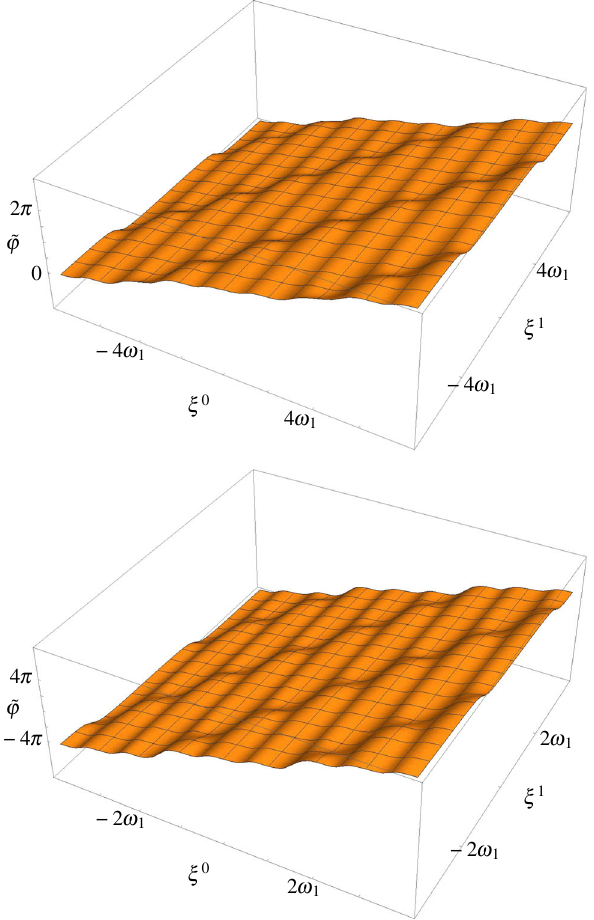
Fig. 7 The solution with D 2 < 0 for two distinct Bäcklund param- eters. The background solution has energy density E = 3 μ 2 / 2 and the Bäcklund parameter takes the value a = 1 . 45482 on the top and a = 1 . 36771 on the